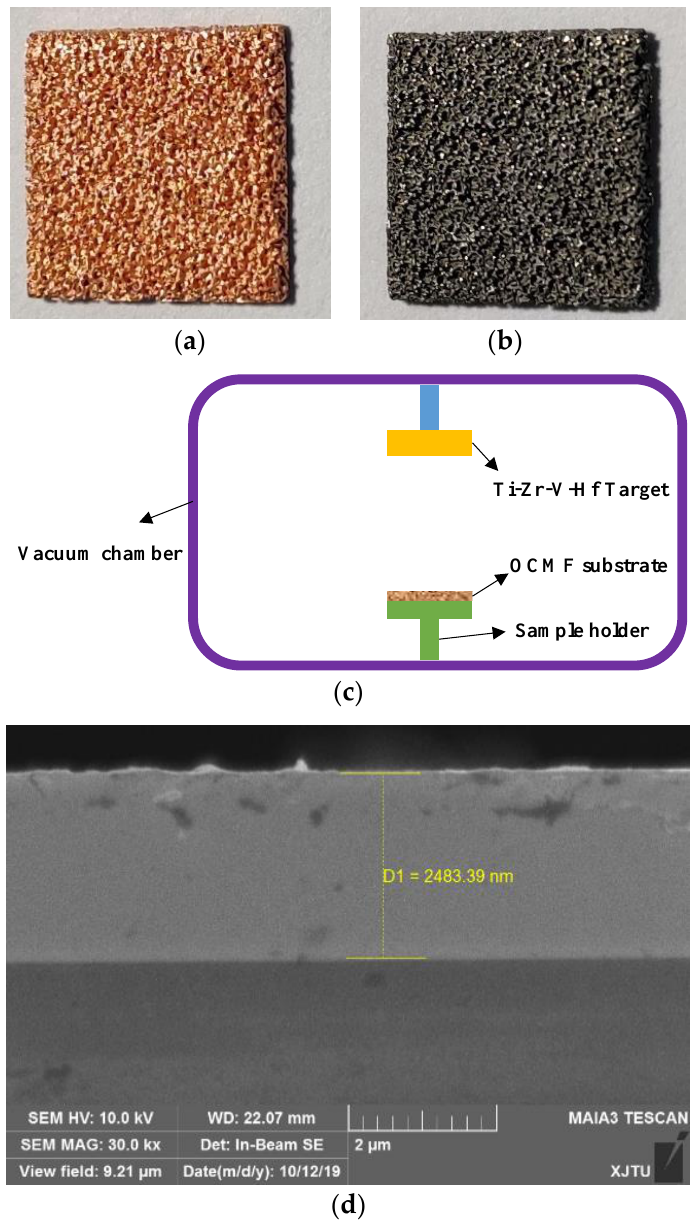
Figure 1. The photos of the open-cell copper metal foam (OCMF) substrates with the pore size of 0.1 mm ( a ) before and ( b ) after film deposition. ( c ) The schematic of the DC sputtering deposition machine. ( d ) The SEM cross-section images of the Ti-Zr-V-Hf film on silicon substrates.